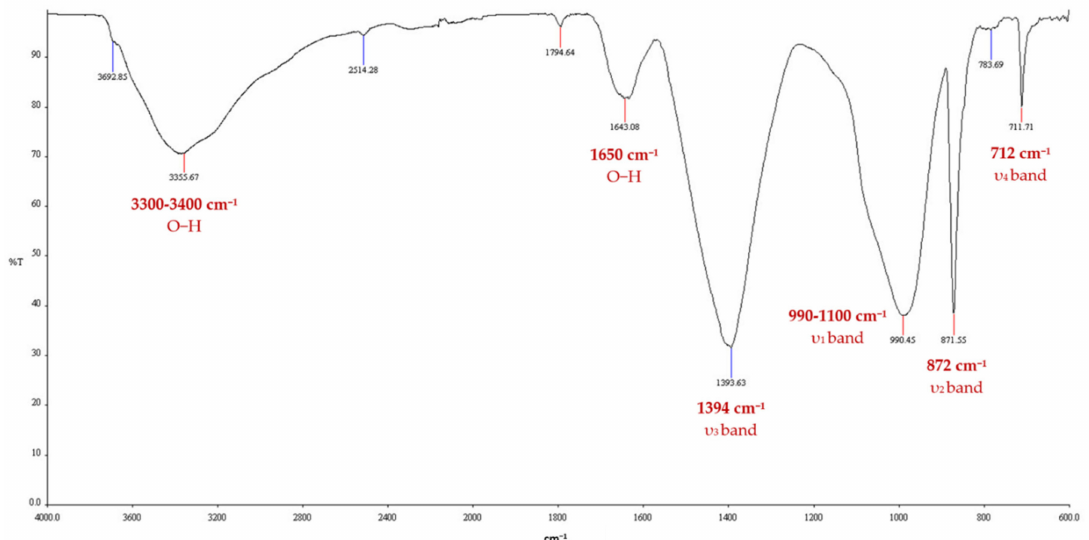
Figure 10. FTIR spectrum of the mineral precipitates in the geopolymer